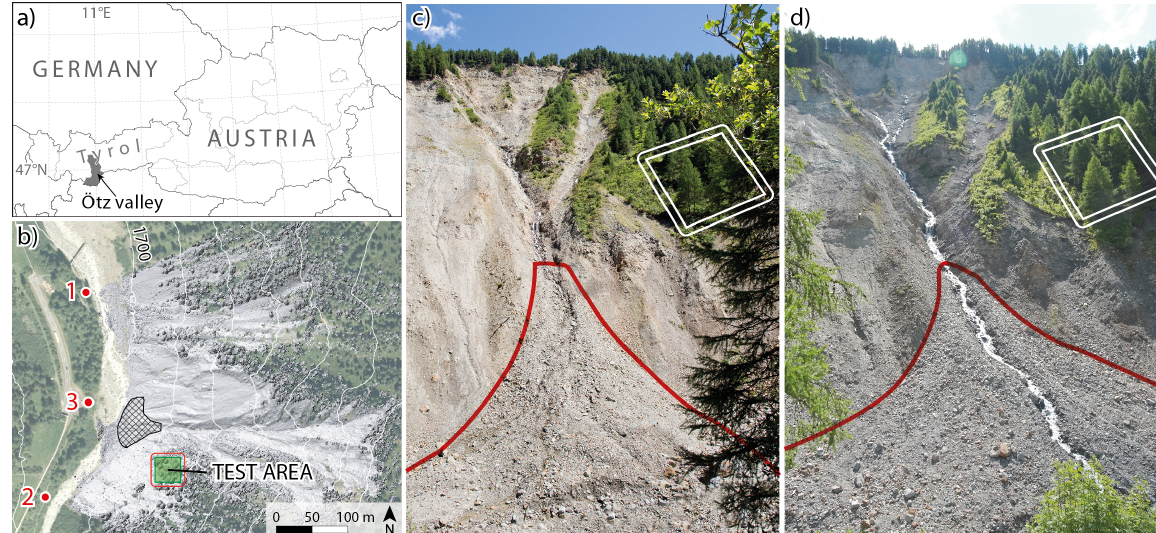
Figure 1. Overview map highlighting the Oetz valley (a); a zoomed in view of the landslide area showing the measurement setup at the landslide site including the scanning positions (red dots), the area covered by the acquired 3D point clouds (shaded relief), the selected 35x35m test area for calibrating and comparing the filtering techniques, and the debris cone (hatched area) (b); photo of the landslide slope taken on 17/07/2017 (c); and photo of the landslide slope taken on 19/06/2019 (d). Orthophoto (2015) and contour lines (2010): Federal state of Tyrol, division of geoinformation. Photos: T. Zieher (c), M. Kuschnerus